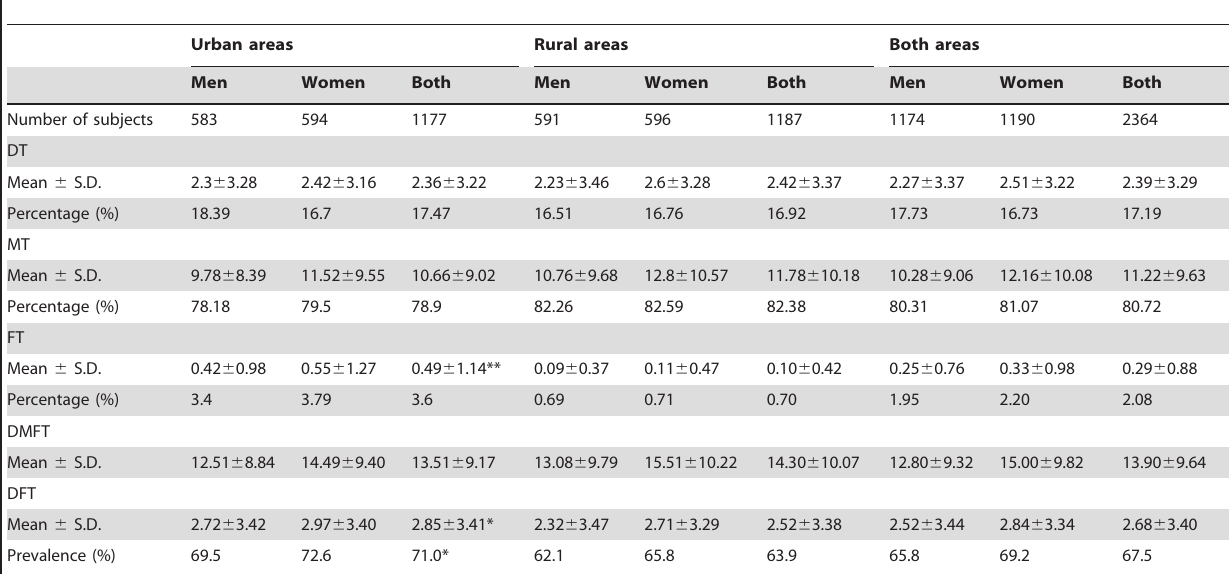
Table 1. Prevalence of dental caries in an elderly population aged 65–74 years old in northeast China.